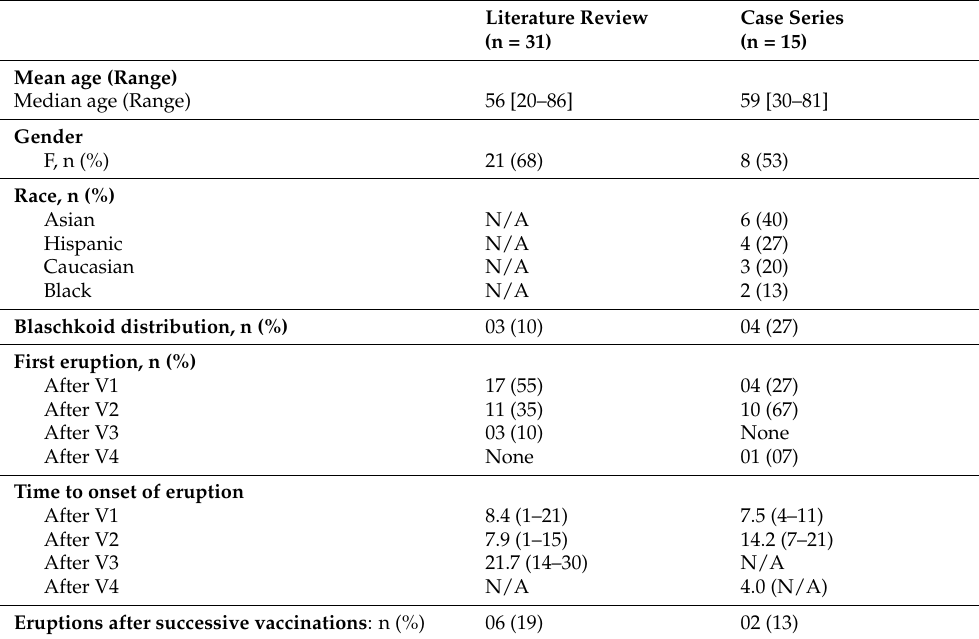
Table 3. Summary of data from literature review and case series of cutaneous lichenoid eruptions associated with COVID-19 vaccination and confirmed by histopathology.